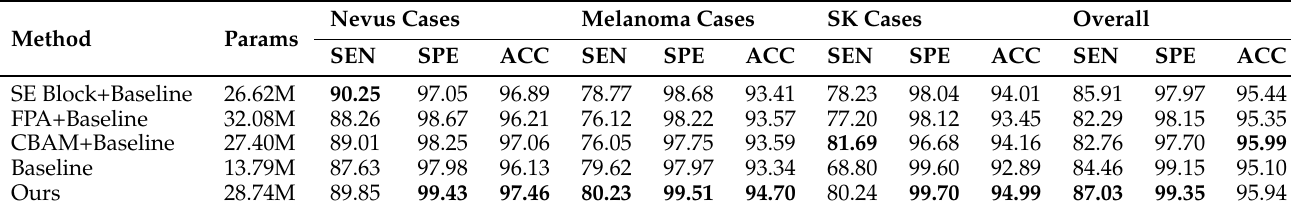
Table 5. Performance evaluation of sensitivity, specificity, and accuracy performance of different attention modules and CSFAG modules on the ISIC-2017 data set using baseline as the basic structure. Bold data indicates that the value is the maximum value in this indicator.